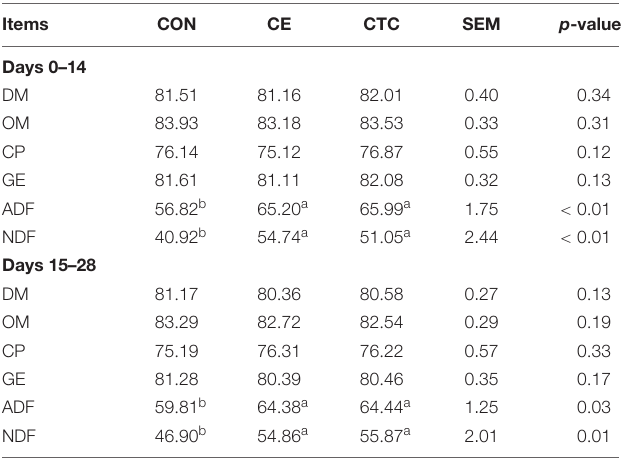
TABLE 3 | Effects of CE on total intestinal apparent digestibility of nutrients in weaned piglets